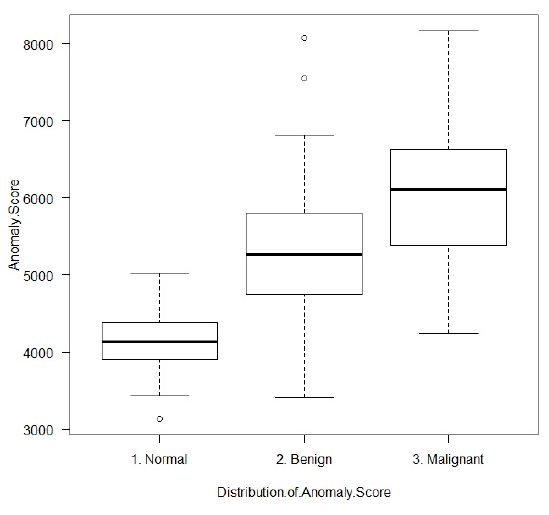
Figure 2. Distribution of anomaly scores.